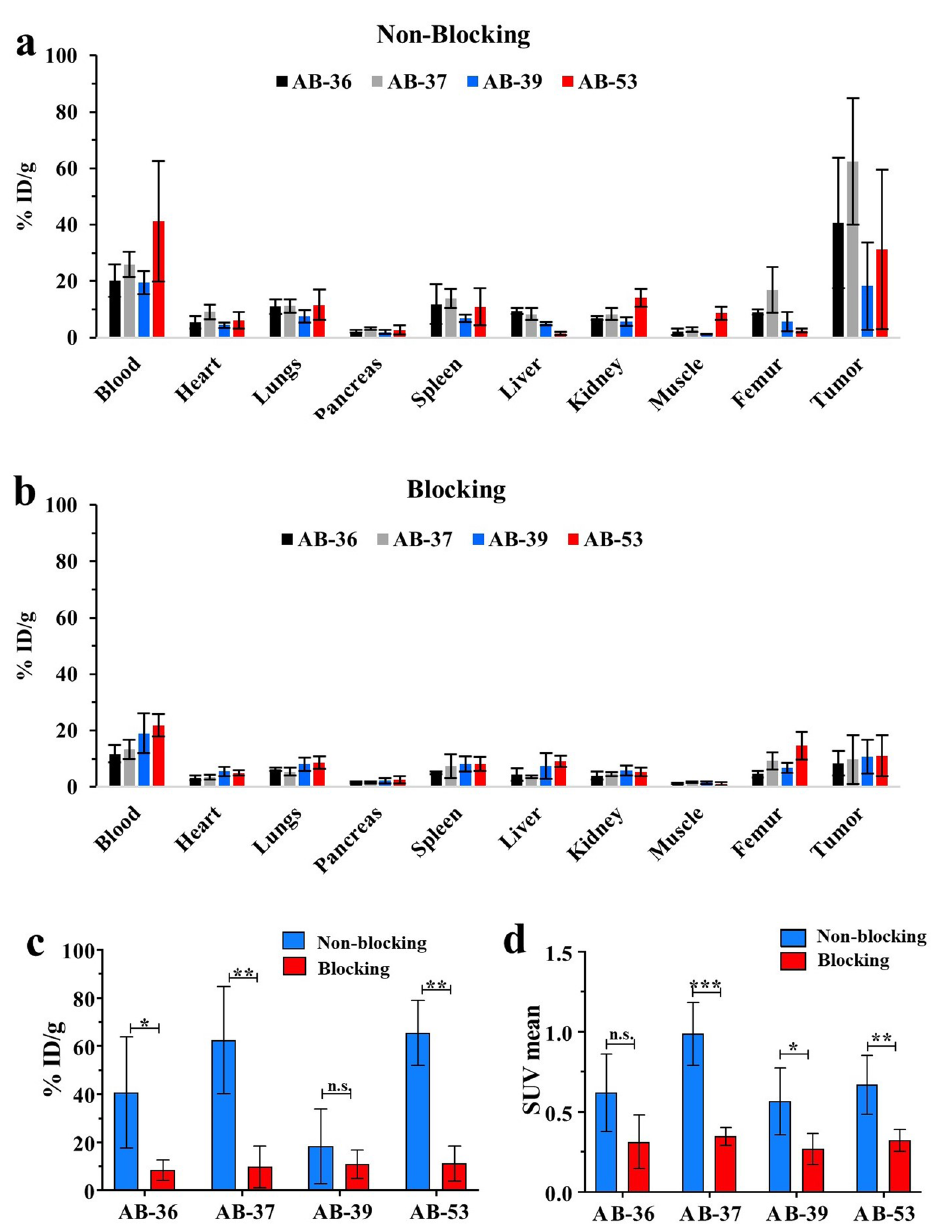
Figure 2. Detection of 89 Zr-panitumumab in ameloblastoma patient derived xenograft models. Ameloblastoma tumor tissue from four patients was implanted in mice (AB-36, AB-37, AB-39, AB-53). All mice received 89 Zr-panitumumab and were imaged at 7 days post injection. In the blocking group, 1 mg of unlabeled panitumumab was given 120 min prior to 89 Zr-panitumumab. ( A ) Systemic biodistribution of 89 Zr-panitumumab in non-blocking vs blocking groups. %ID/g = % injected dose per gram. ( B ) Average tumor uptake of 89 Zr-panitumumab. ( C ) Standardized uptake value (SUV) in each tumor group. *p < 0.05; **p < 0.01; ***p < 0.001. Error bars indicate standard